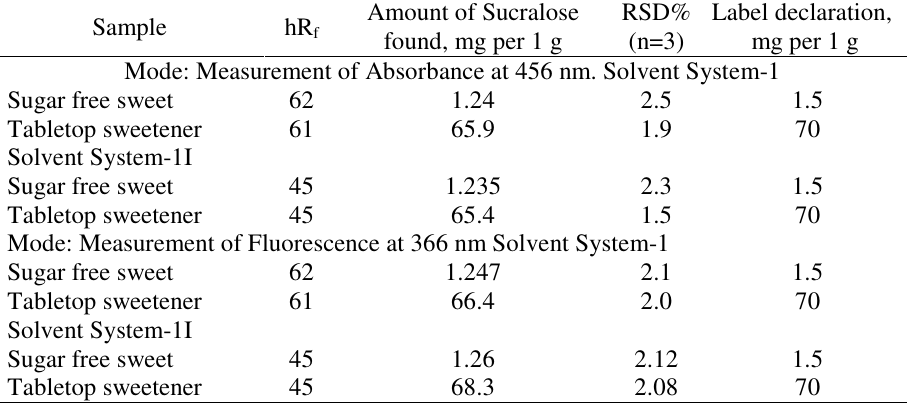
Table 3. Data for recovery of sucralose in real samples obtained using two solvent systems after derivatization with rhodamine-sulfuric acid reagent in absorbance mode at 456 nm and in fluorescence mode at 366